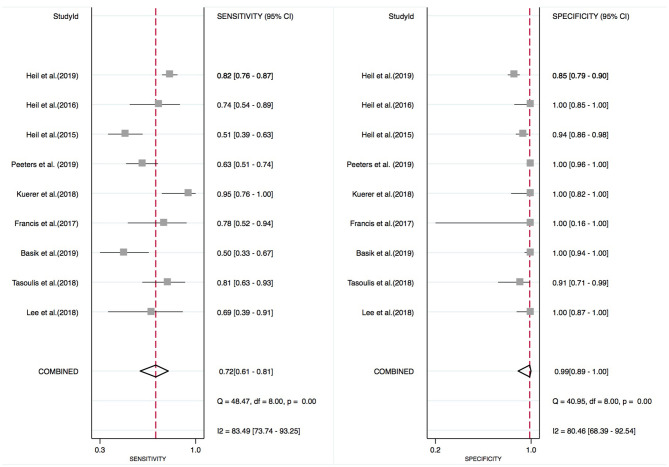
Forest plot of meta-analysis on pooled sensitivity and specificity of MIB.